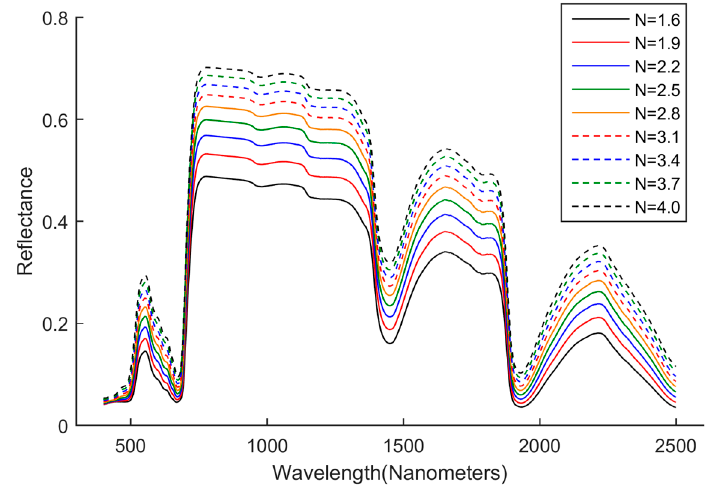
Figure 4. The modeled reflectance generated by PROSPECT-5 with different N . ( C ab , C car , C w , and C m are fixed as 33 μ g/cm 2 , 8.6 μ g/cm 2 , 0.012 cm, 0.005 g/cm 2 , respectively).